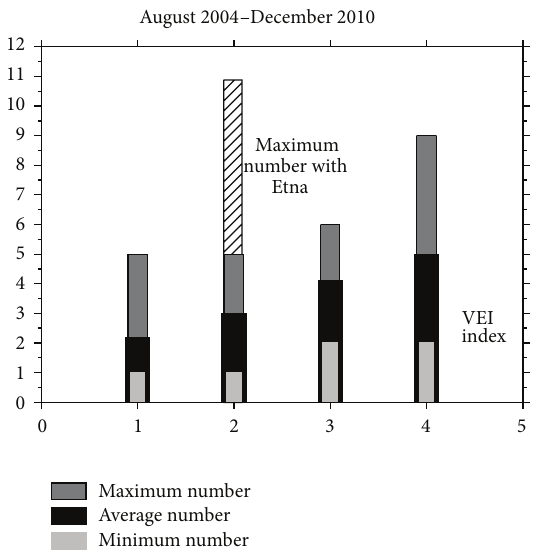
Figure11:Maximum,average,andminimumnumbersofanomalies versus the Volcanic Explosivity Index (VEI, http://vulcan.wr.usgs .gov/News/MSH2004/VEI